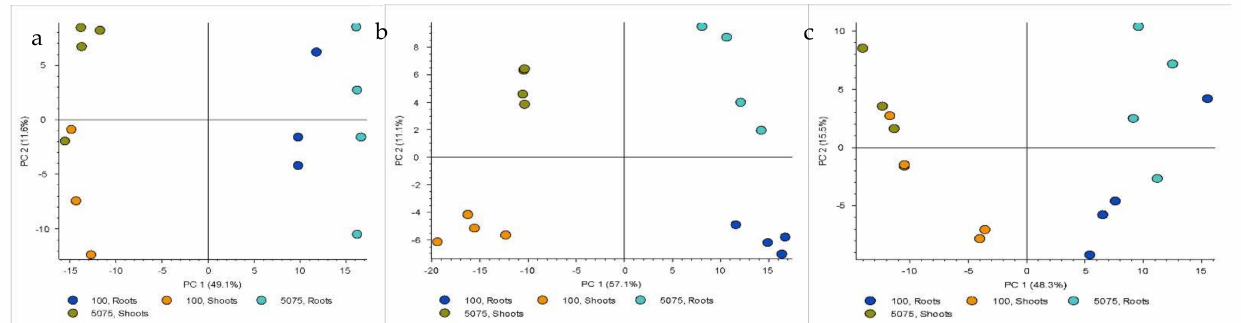
Figure 6. Principal component analysis (PCA) score plots of secondary metabolic profiles in roots and shoots for ( a ) M. arborea (M. ar), ( b ) M. sativa (M. sa) and ( c ) Alborea (Al): ( a – c ). Shoots (yellow) and roots (dark